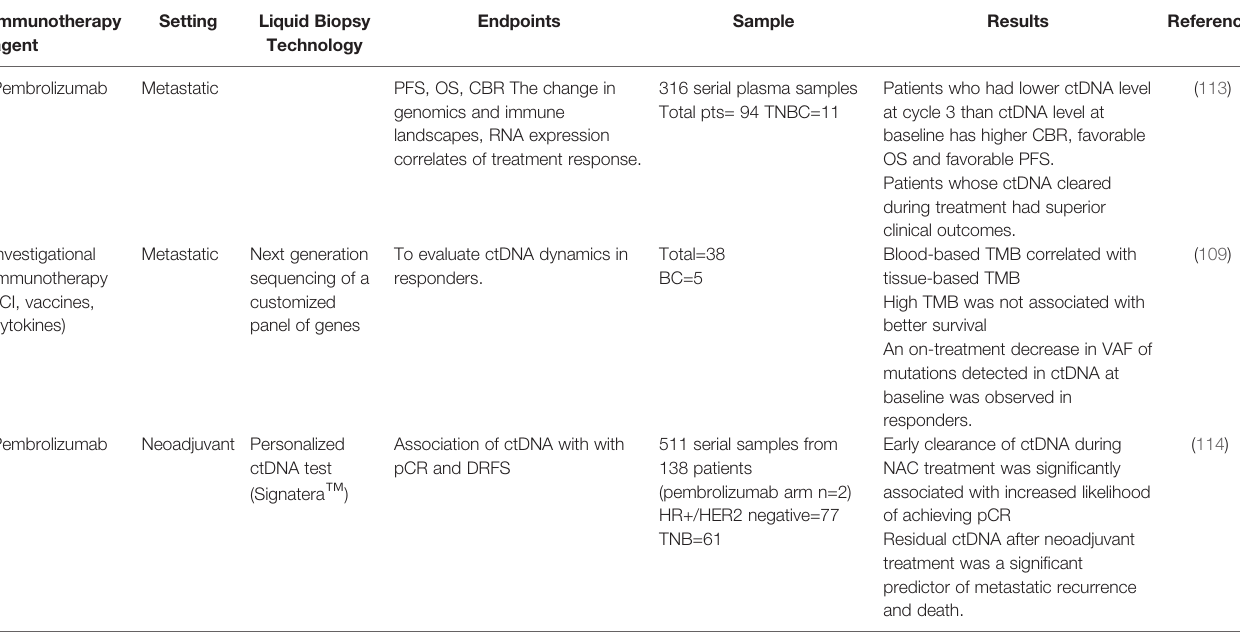
TABLE 3 | Studies on ctDNA in breast cancer patients receiving